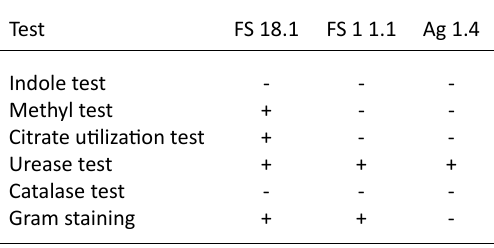
Table 1. Bio-chemical Characterization of